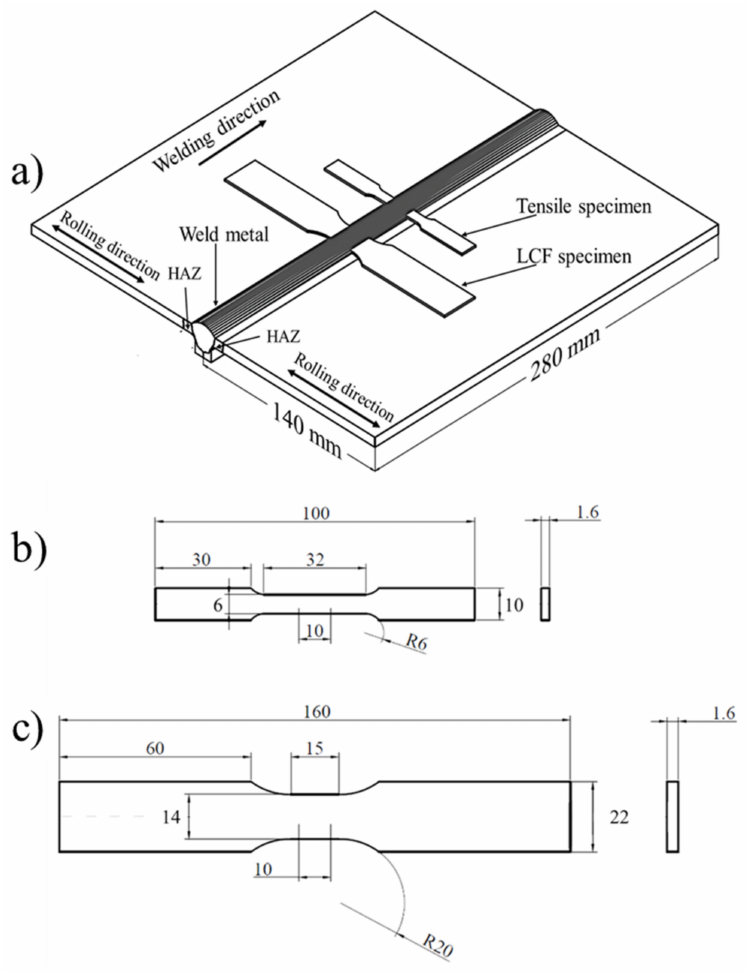
Figure 2. ( a ) Schematic representation of welded joint and the specimens located. ( b ) Specimen geometry used for tensile tests and ( c ) for LCF tests. All dimensions are in